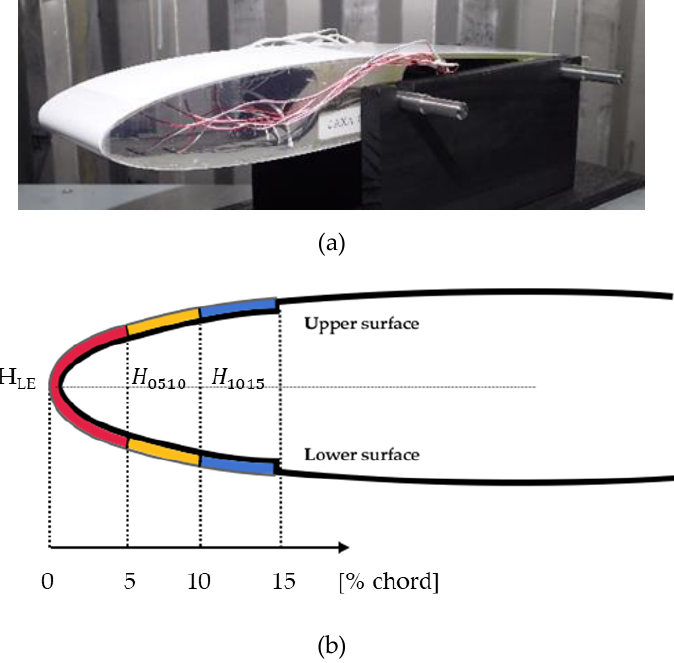
Figure 3. ( a ) Validation model and ( b ) heating areas at leading edge region of the NACA0012 model for the validation test.